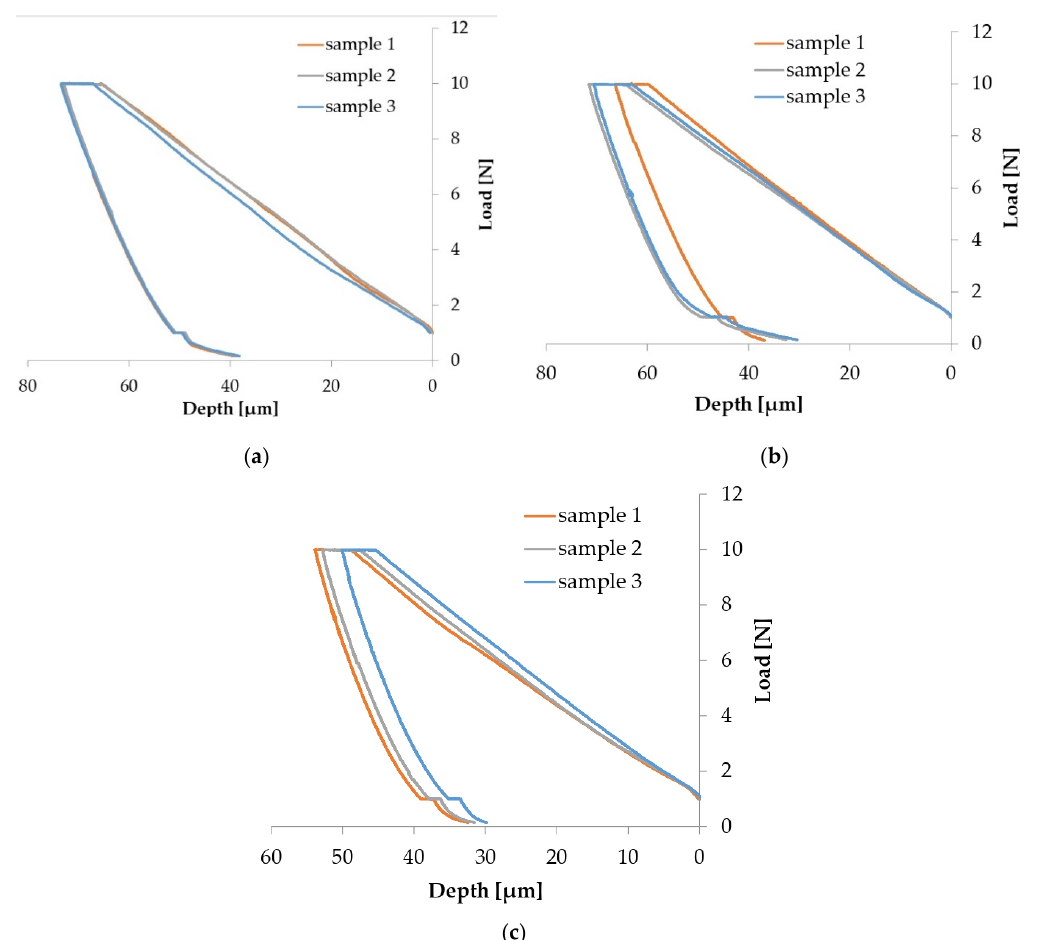
Figure 10. Results of microindentation tests for samples coated with ceramic micropowders: ( a ) P3–143–9 passes; ( b ) P6– 6420–9 passes; ( c ) P9–136–9 passes.